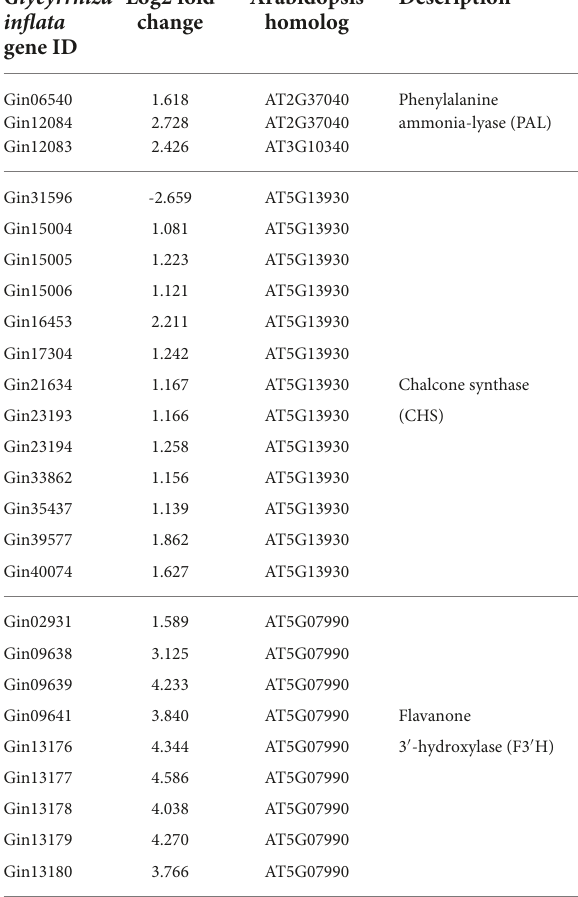
TABLE 1 Phenylpropanoid/flavonoid pathway genes identified in